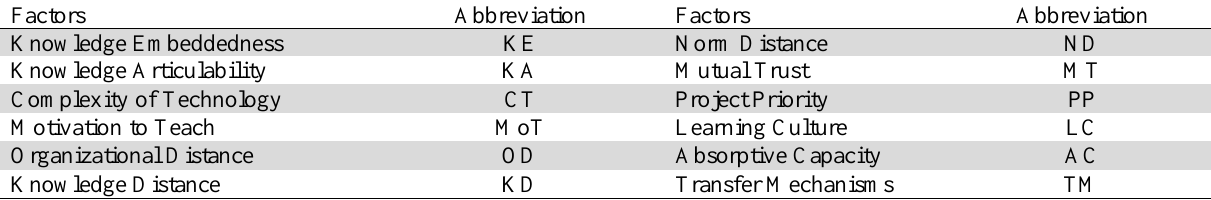
Factors of final proposed